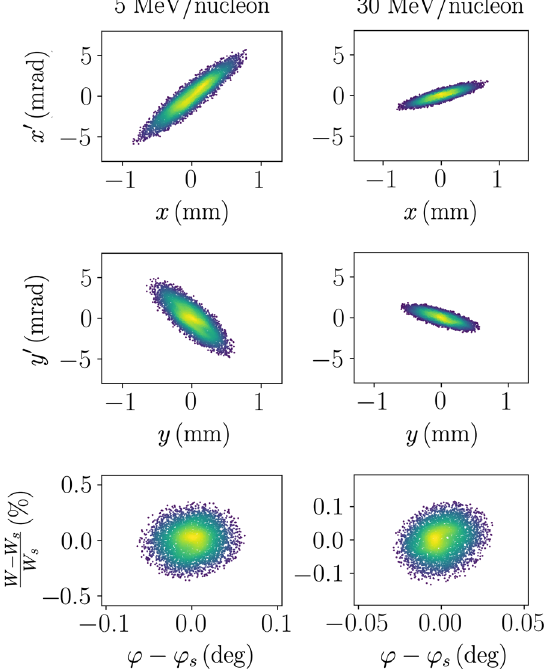
FIG. 5. Beam distributions at the entrance ( 5 MeV = nucleon, left diagrams) and exit ( 30 MeV = nucleon, right diagrams) of the full QA-DTL option. Note the different scales for the φ - W plane.